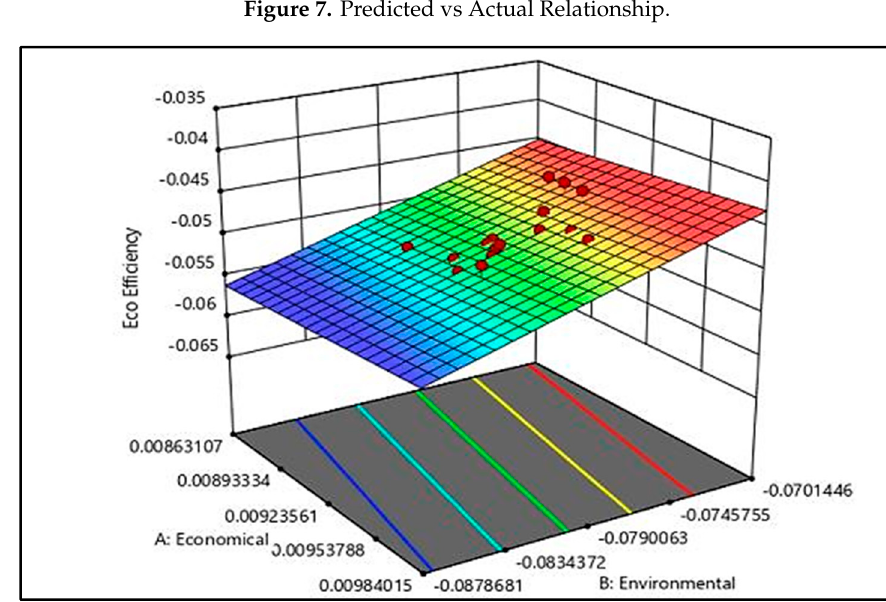
Figure 8. Surface Model Graph